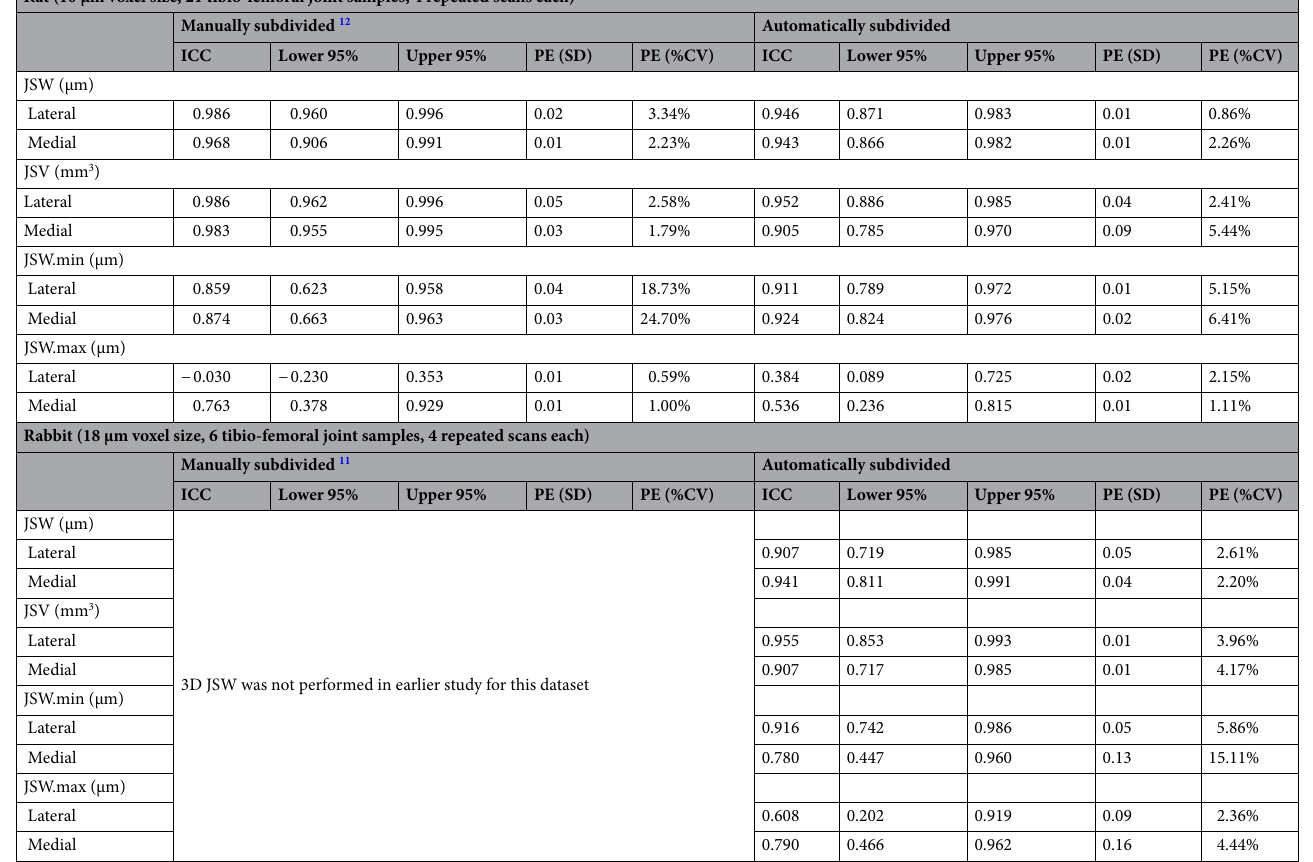
Table 3. Reproducibility of the rat and rabbit joint space measurements in terms of intraclass correlation coefficient (ICC) and precision errors (PE) expressed in absolute and a percentage of the coefficient